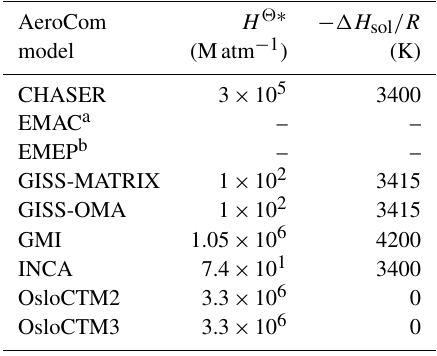
Table 5. Effective Henry’s law constant used in the